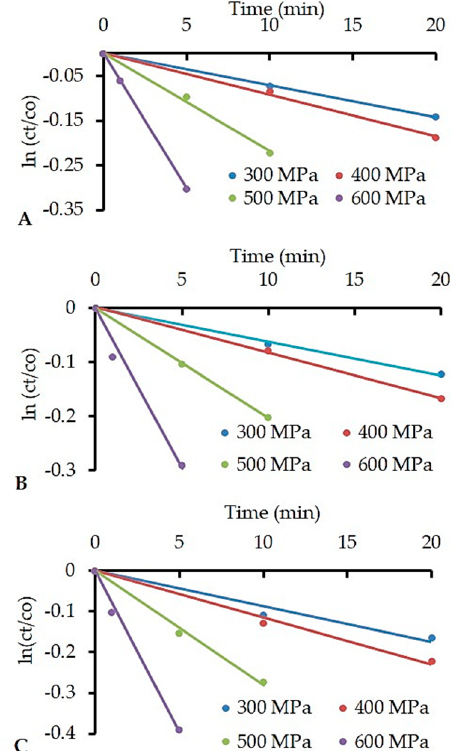
Figure 2. High-pressure denaturation of alpha-lactalbumin ( α -Lac), HPP applied at ~20 °C ( A ), ~30 °C ( B ), and ~40 °C ( C ). Temperature at all HPP conditions ( T eff ) is presented in Table 1. The concentration of α -Lac is expressed as c t / c o , where c t = α -Lac concentration after HPP and c o = initial α -Lac concentration before HPP.